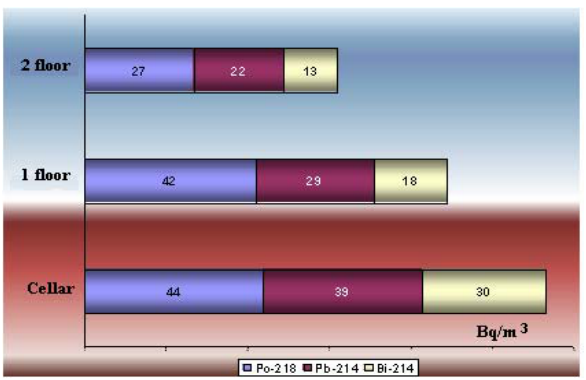
Fig 5. Amount of radon and radon progenies on separate floors